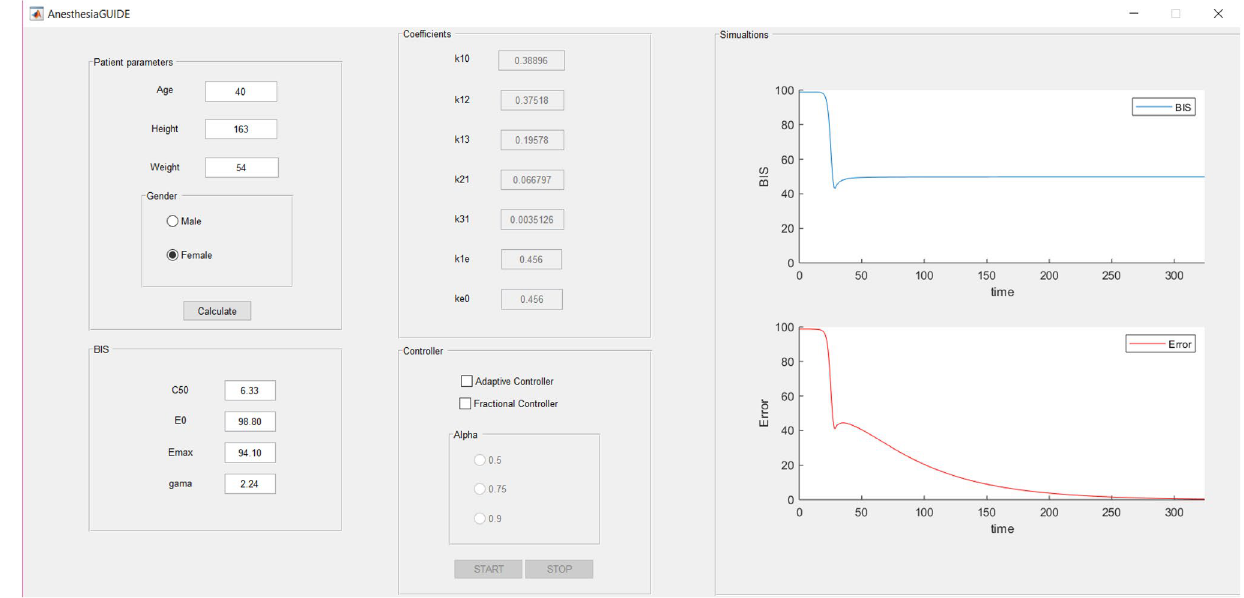
Fig. 4 AnesthesiaGUIDE tool window